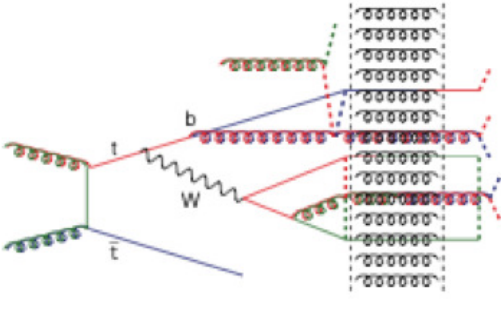
Figure 4. The top decay in the string hadronization models